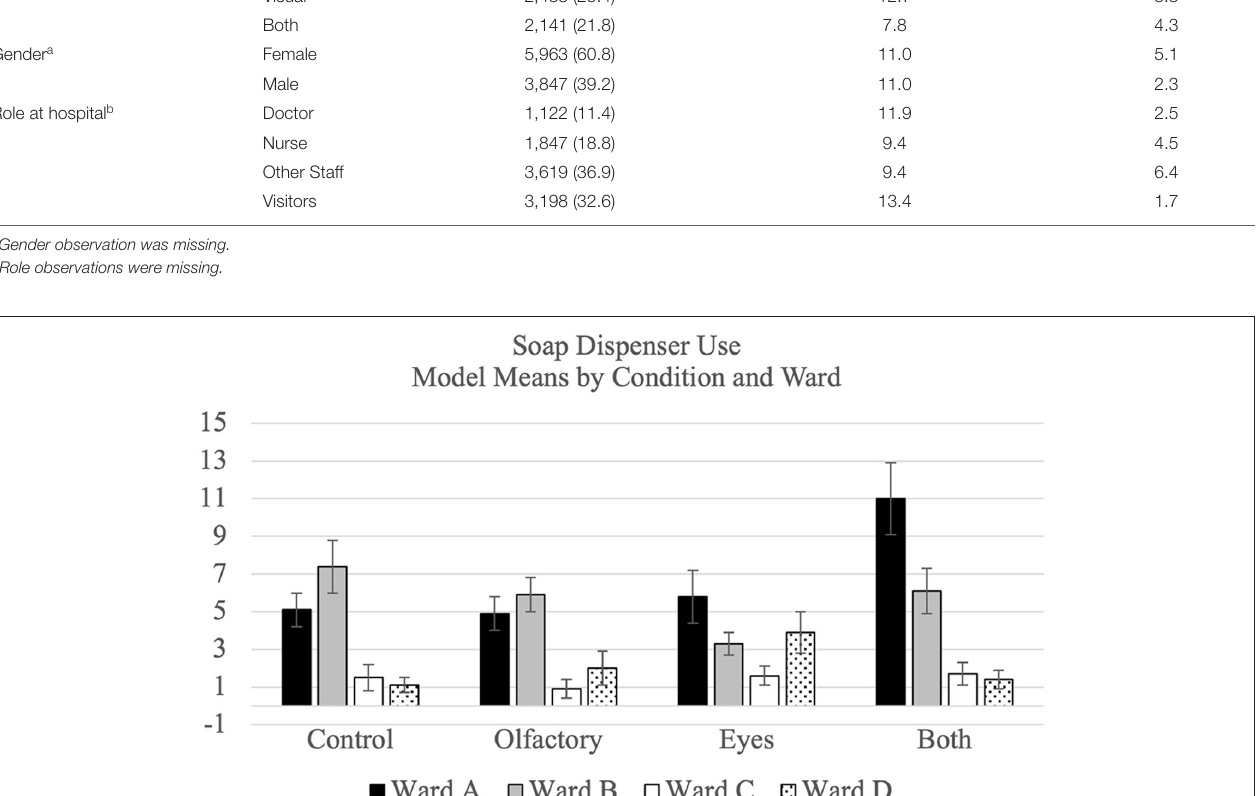
Percentage Percentage Gel-Dispenser-Use Soap-Dispenser-Use